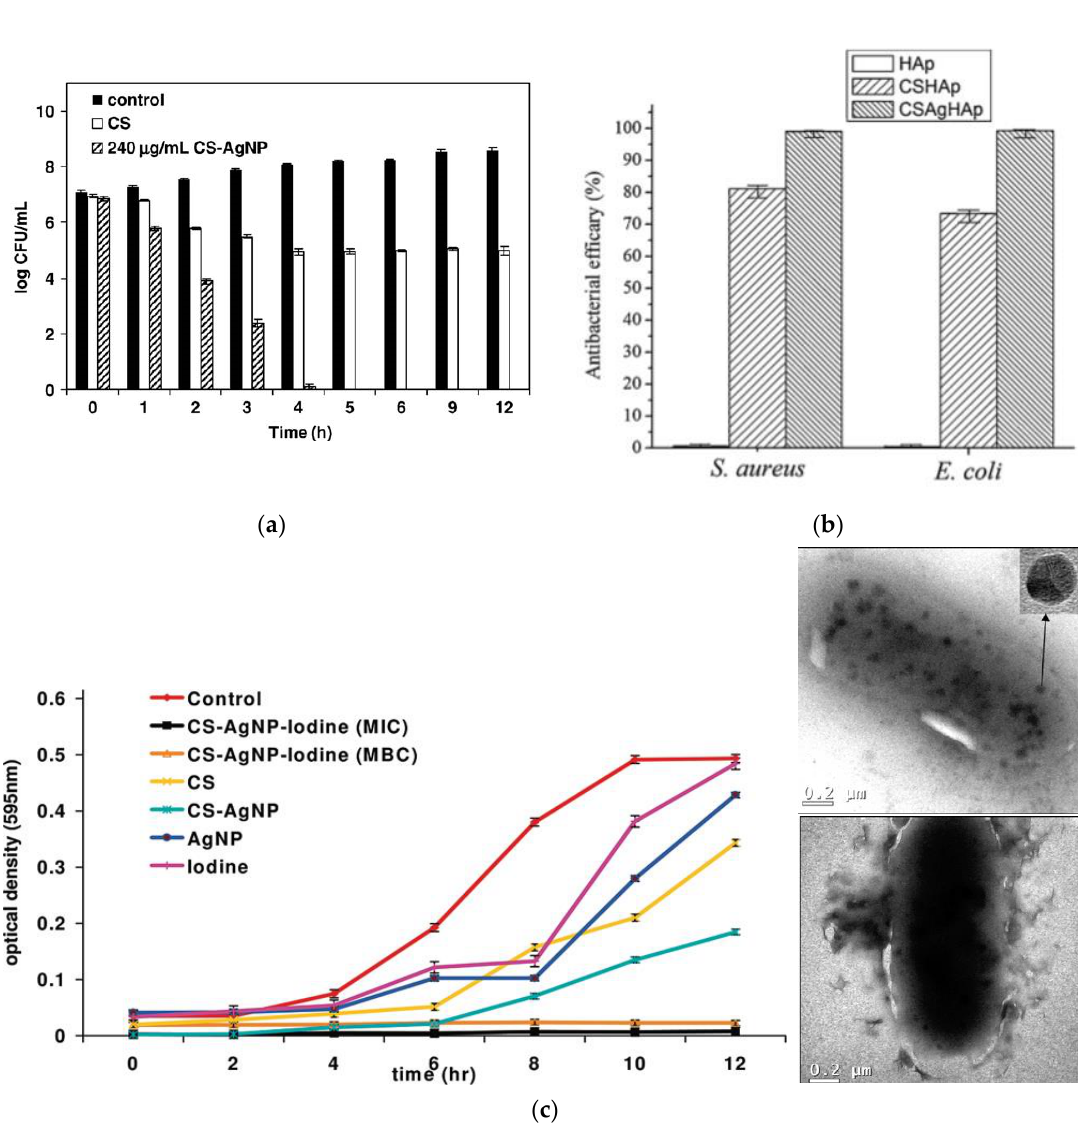
Figure 4. Examples of the result of the combination of polysaccharides and derivatives with AgNPs. ( a ) Comparative effect of CS–AgNPs composite and chitosan, alone (with same 0.024% conc. of CS in both the samples), on recombinant E. coli viability. CS represents chitosan [120]. Copyright 2008 Elsevier. ( b ) Antibacterial effect of the prepared CSAgHAp coating against E. coli and S. aureus strains [143]. Copyright 2015 Elsevier. ( c ) Effect of different concentrations of iodinated chitosan–AgNP (at MIC and MBC) and individual components of the composite on the growth of GFP recombinant E. coli . Sample TEM micrographs showing interactions between silver nanoparticles in the iodinated composite and bacteria. Reprinted with permission from Langmuir 2010, 26(8), 5901–5908. Copyright 2010 American Chemical Society [156].